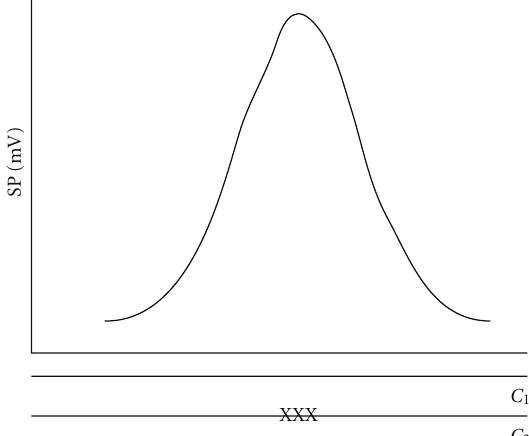
Figure 2: A profile of the self-potential anomaly produced by a horizontal flow perpendicular to the paper. The location of the flow is indicated by the symbols XXX (Schiavone and Quarto